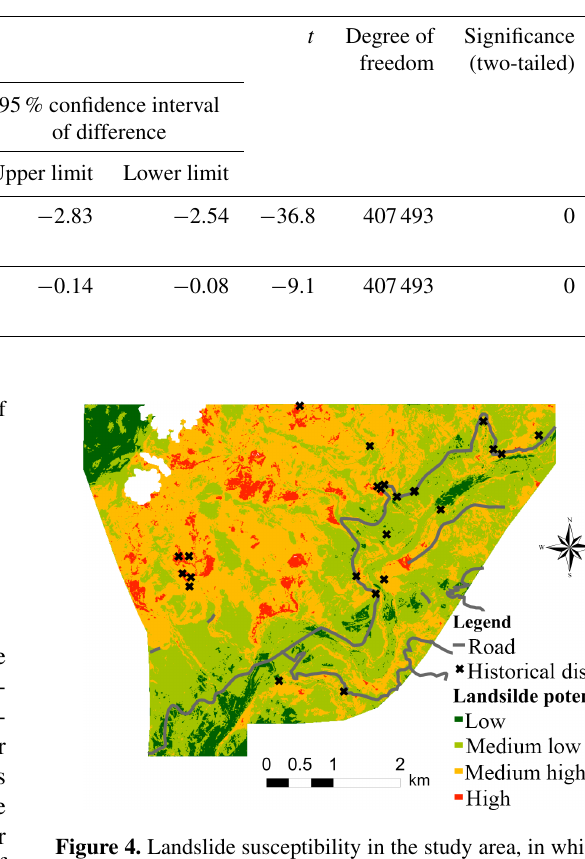
Figure 4. Landslide susceptibility in the study area, in which cross symbols represent the historical disasters collected from NCDR